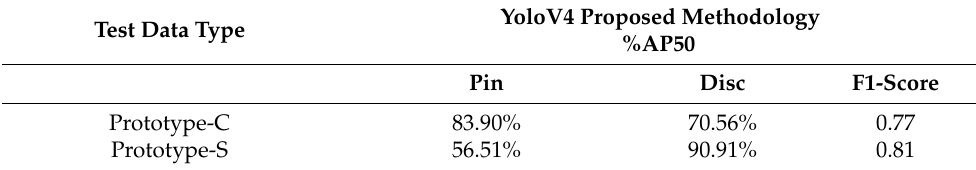
Table 5. Results of proposed YoloV4 fine-tuning on faulty disc insulators using proposed flight path